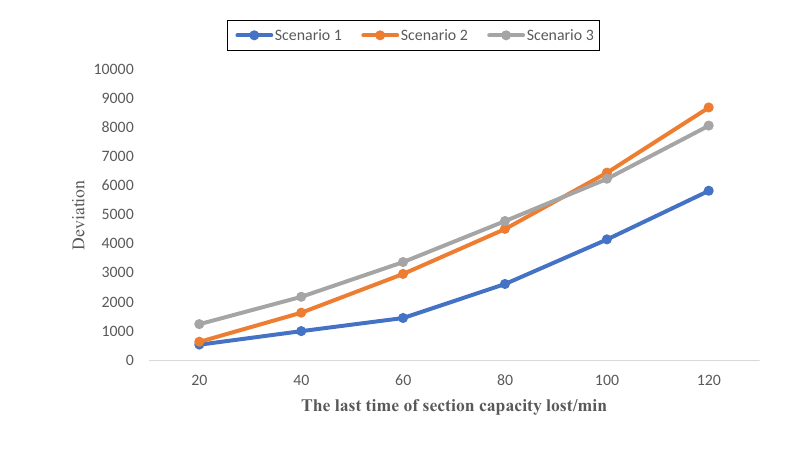
Figure 4. Sensitivity